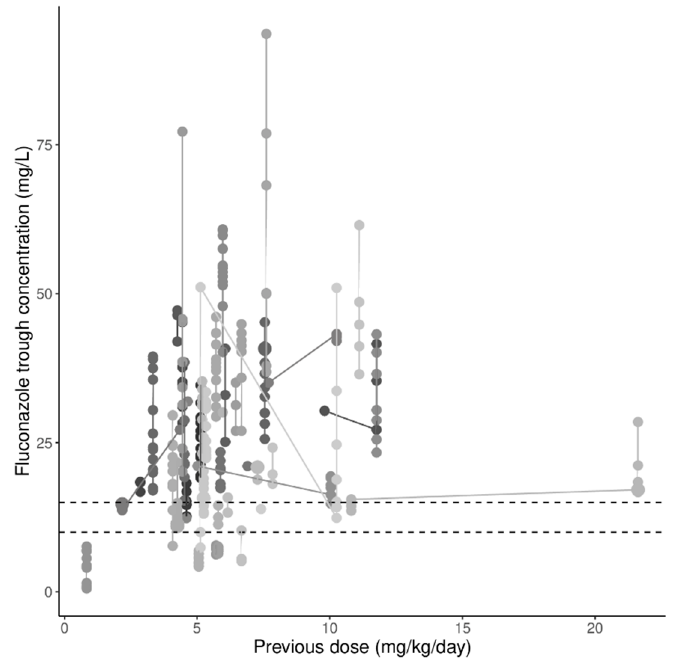
Figure 1. Fluconazole trough concentrations as a function of the previously administered daily dose. The grey scale represents concentrations in individual patients. Points of individual patients are connected with a solid line. The horizontal dashed lines depict the 10 and 15 mg/L thresholds.